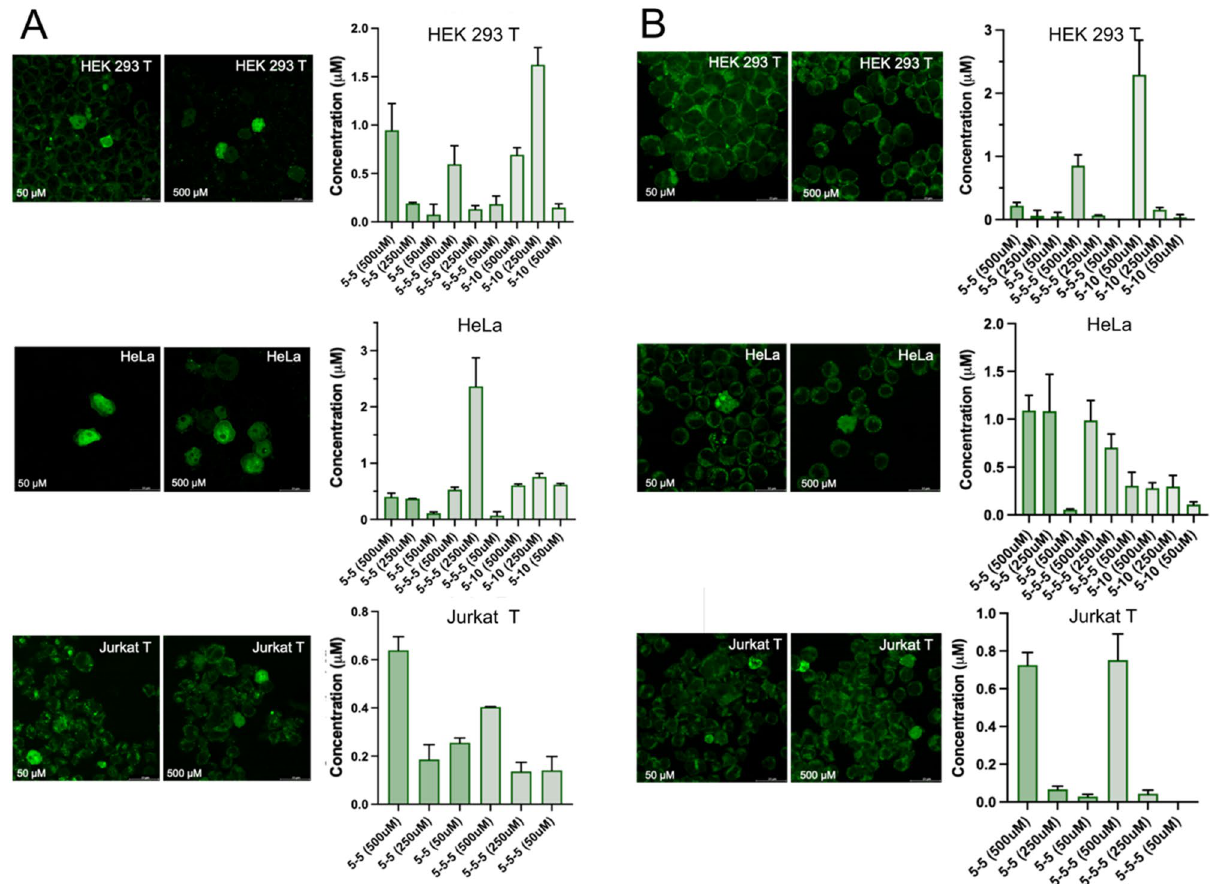
Figure 3. ( A -left) Confocal images acquired on the delivered cells with Ubiquitin-A28C-atto488 protein. Column A was acquired on cell samples delivered with 50 μM external protein concentration, while the cells in the column B were delivered with 500 μM external concentration using the HS 5-5 delivery set-up. (A-right) In-gel fluorescence PAGE derived bulk intracellular concentration respectively for the Ubiquitin-atto488 under different HS delivery set-up (Supplementary Information, Figs. S1–S3). ( B -left) Confocal images acquired on GFP delivered cells delivered with the HS 5-5 delivery set-up. Cells in column C were delivered with 50 μM external concentration while those in column D were treated with an external concentration of 500 μM. ( B -right) Western Blot derived bulk intracellular concentration respectively for the GFP delivered cells under different HS delivery set-up (Supplementary Information, Figs.